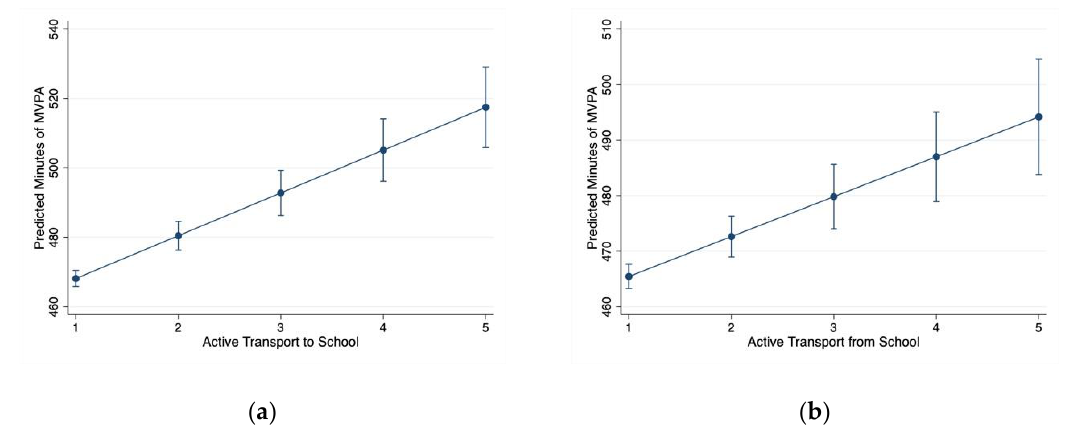
Figure 1. Marginal predicted effects on self-reported school week moderate-to-vigorous physical activity as a function of self-reported active transport to and from school. ( a ) Relationship between active transport to school and predicted weekly minutes of MVPA; ( b ) Relationship between active transport from school and predicted weekly minutes of MVPA. Note: bars are 95% confidence intervals.